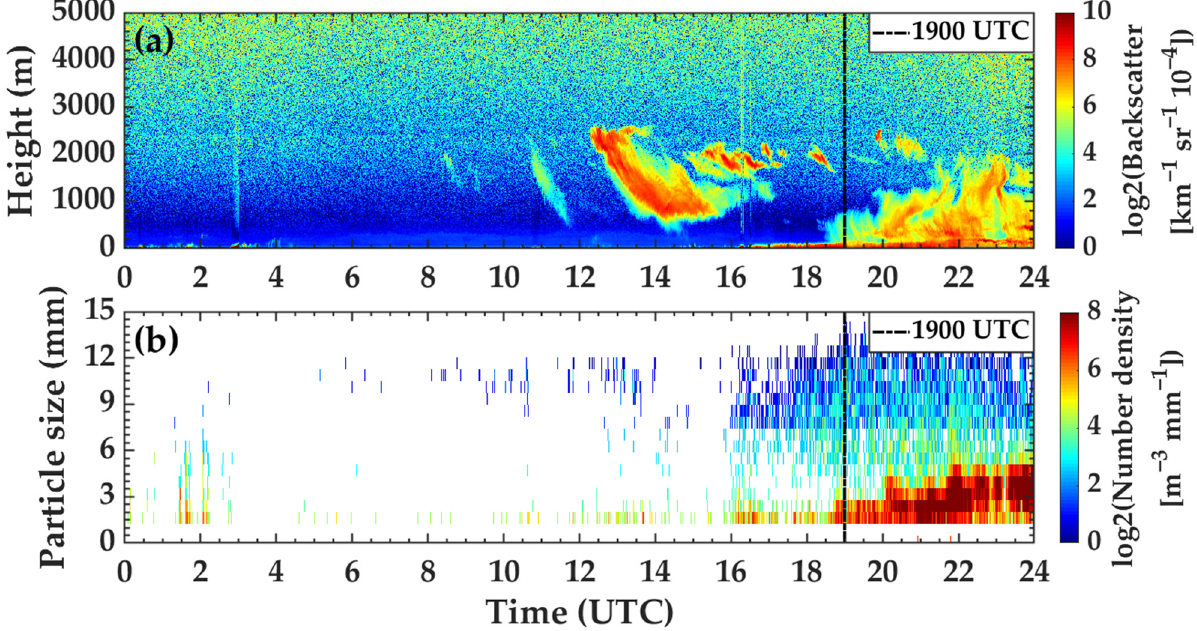
Figure 10. ( a ) Backscattered echo map of ceilometer and ( b ) the average particle number density of parsivel 2 on 8 April 2016. Black dotted line corresponds to 1900 UTC.